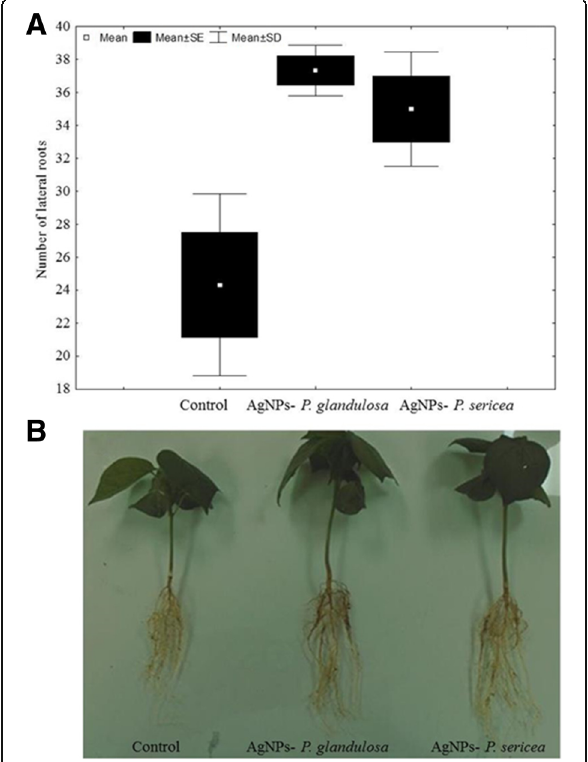
Fig. 2 Effects of AgNPs from P. sericea and P. glandulosa on stomata conductance ( a ) and optimum quantum yield ( b ) in leaves of cotton plants after 30 days of treatment (values are expressed as mean ± S.D., n = 10)